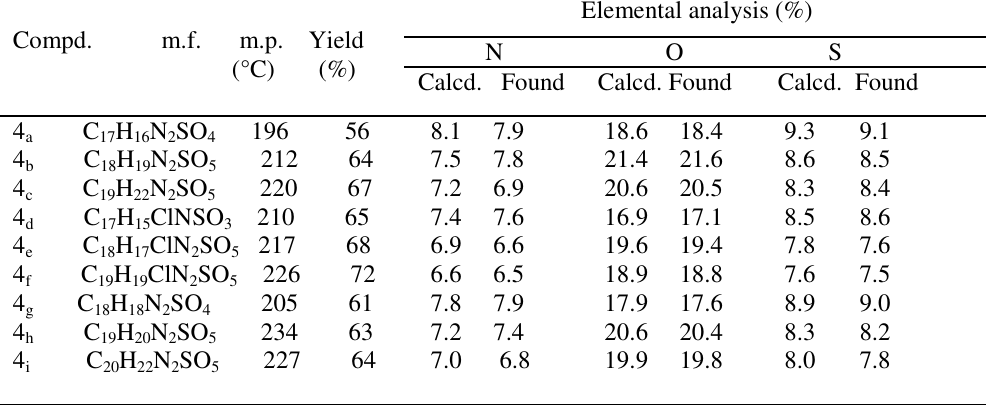
Table 1.Characterisation data of compounds (4